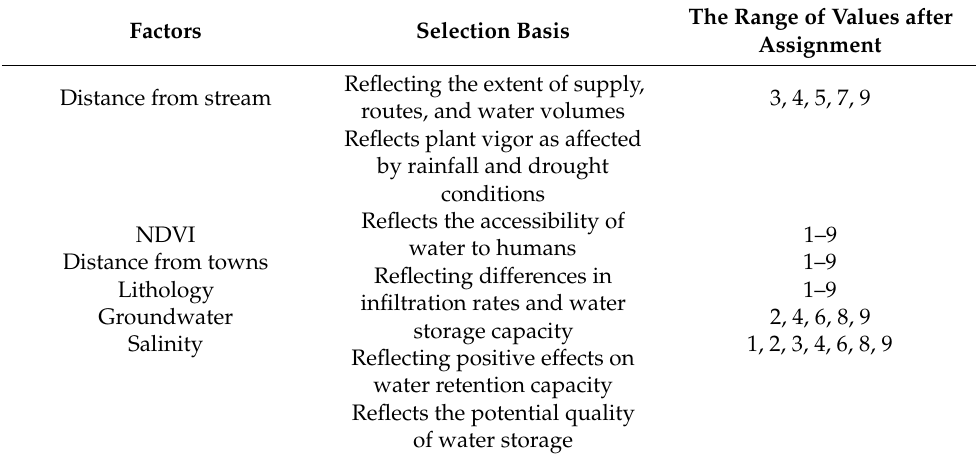
Table 1. Screening of regional suitability